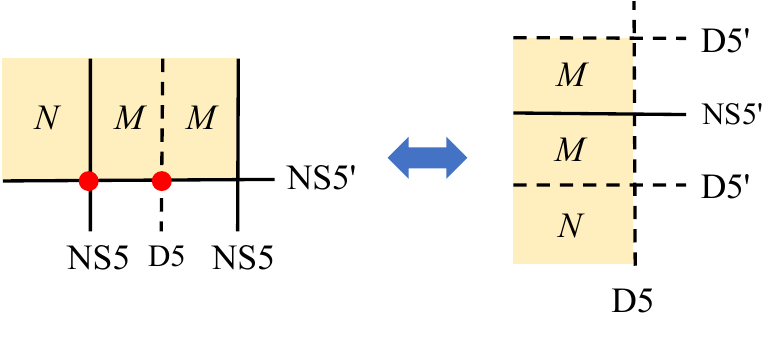
Figure 13 . The brane constructions of the configuration 4d U( N ) ( , N (cid:31) ) and its mirror corner configuration that has no gauge N (cid:31)